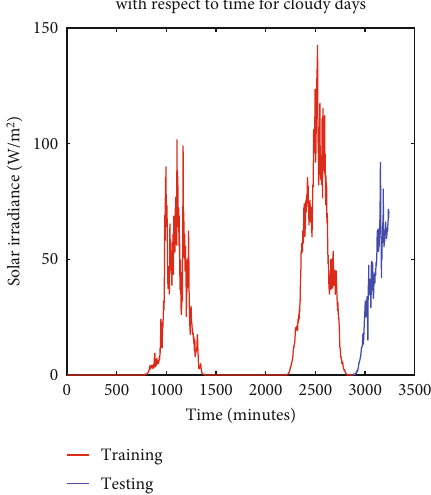
Figure 2: Sunny day dataset training and testing samples.